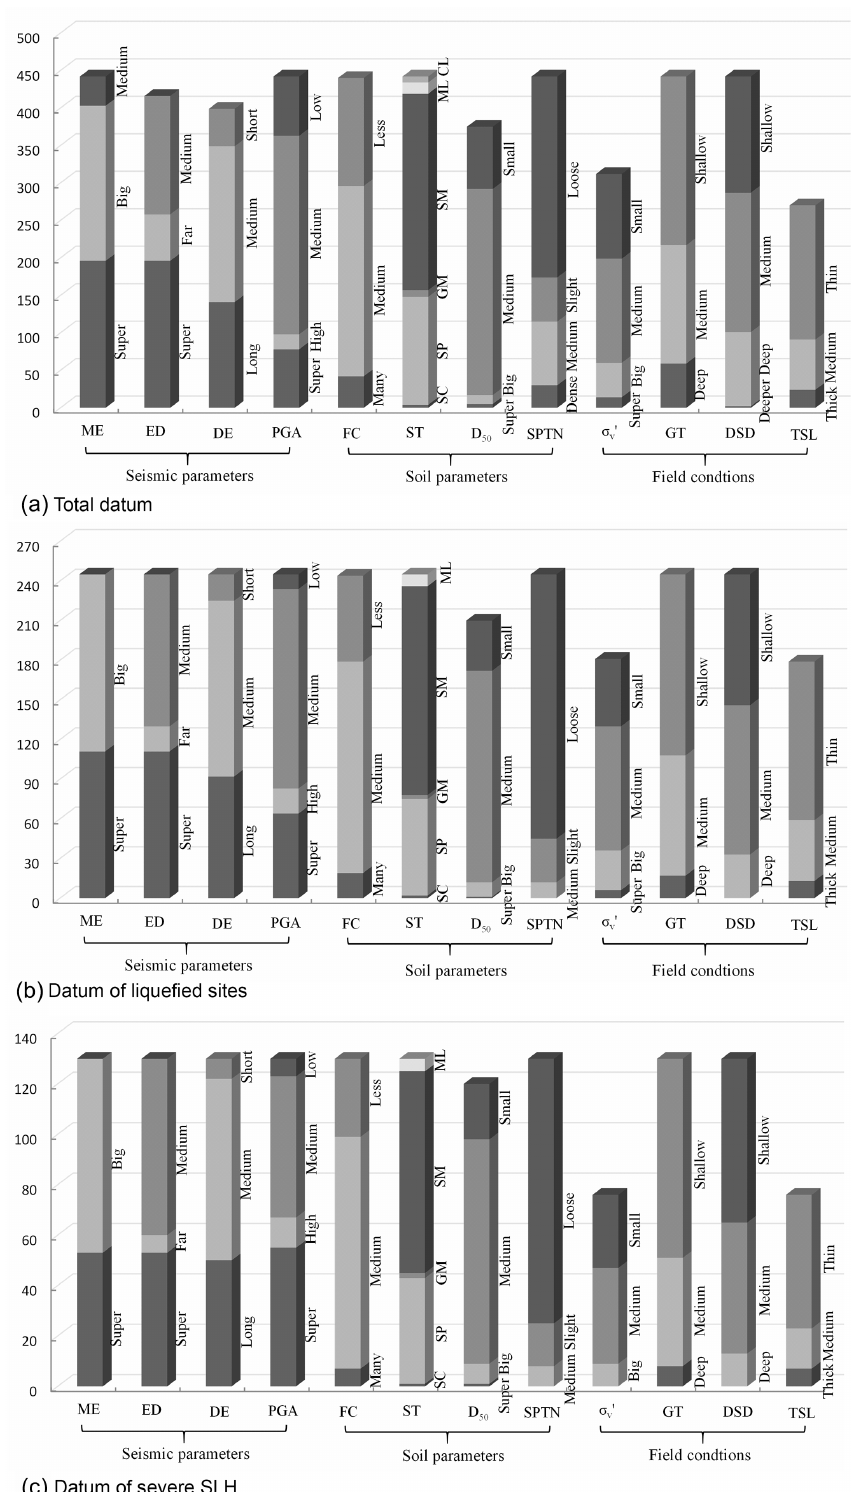
Figure 5. Proportions of data size of all influence